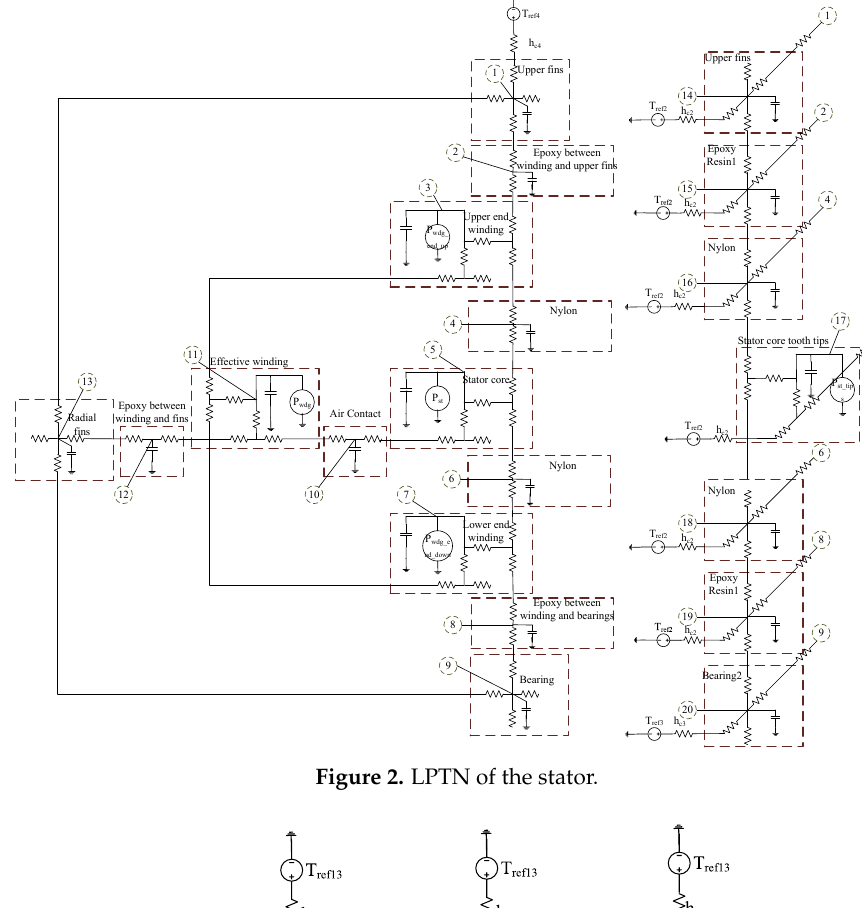
Figure 2. LPTN of the stator.